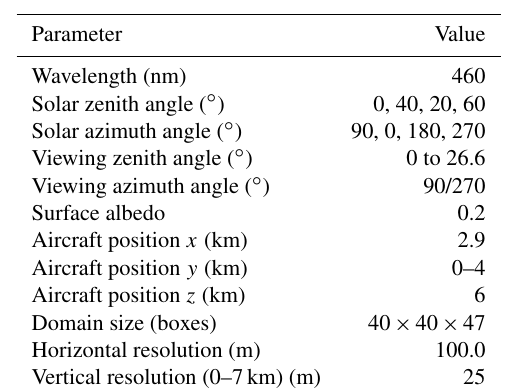
Table 1. MYSTIC input parameters for the emission stack